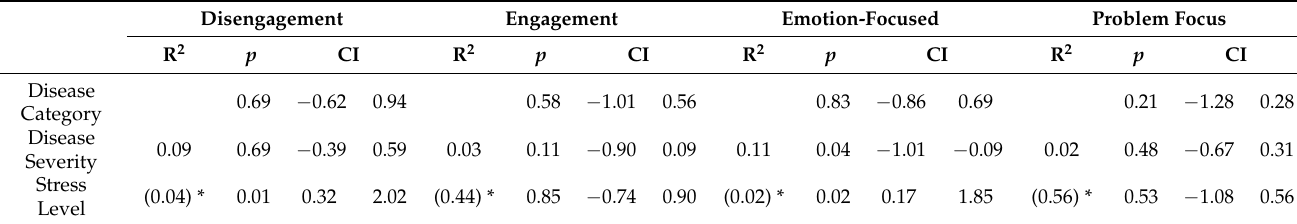
Table 3. Regression analysis by coping strategy Ordinal regression model to observe if disease category, disease severity, and stress level determine the use of disengagement, engagement, emotion-focused, and problem focus types of coping. Disengagement Engagement Emotion-Focused Problem Focus R 2 p CI Disease 0.69 Category Disease Severity Stress